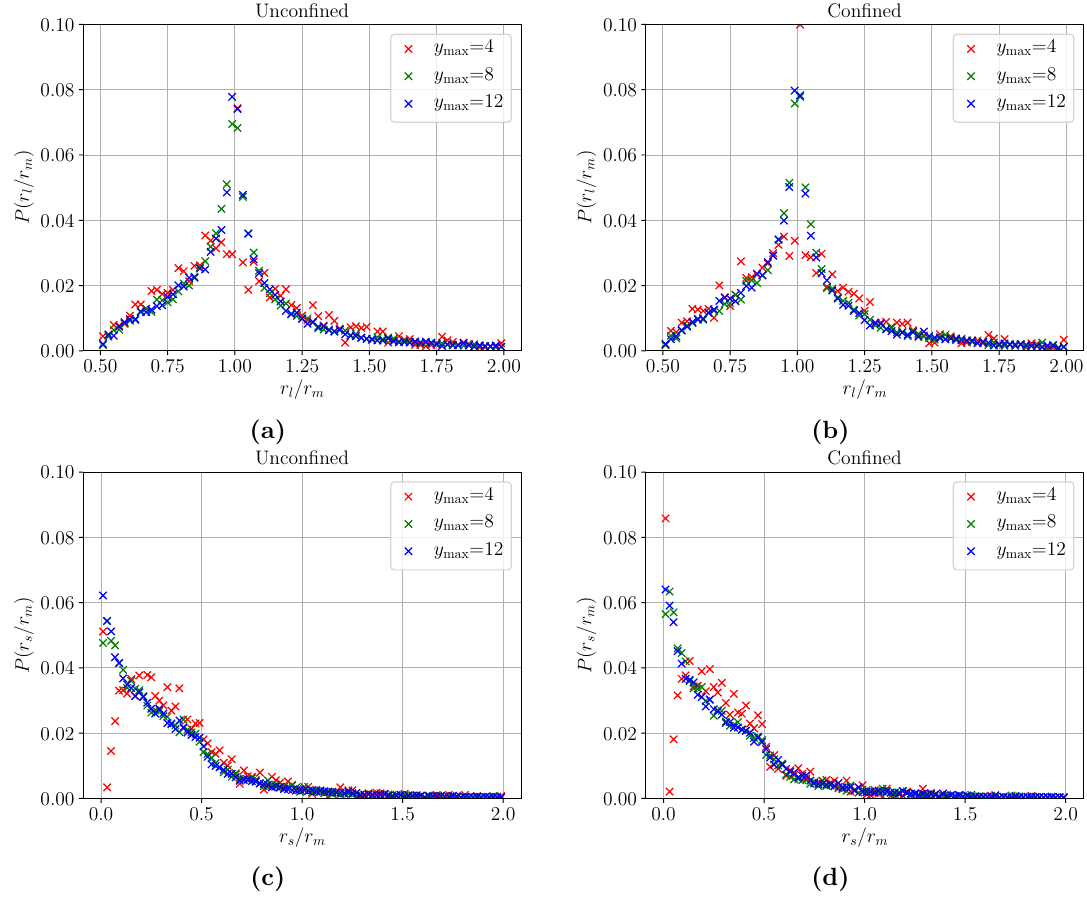
Figure 3. The scaled lengths of the daughter dipoles w.r.t. the mother dipole as a function of maximal rapidity for uncon(cid:12)ned (a,c) and con(cid:12)ned (b,d) dipole-evolution. Figures (a,b) shows the larger of the daughter dipoles, while (cid:12)gures (c,d) shows the smaller of the daughter dipoles. The parameters used in the dipole evolution are the same as presented in table 1.